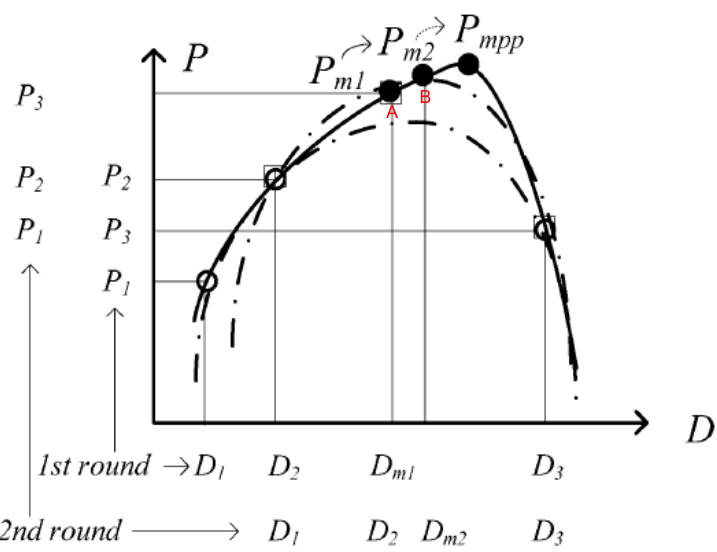
Figure 18. Non-linear predictor MPP method tracking [63].